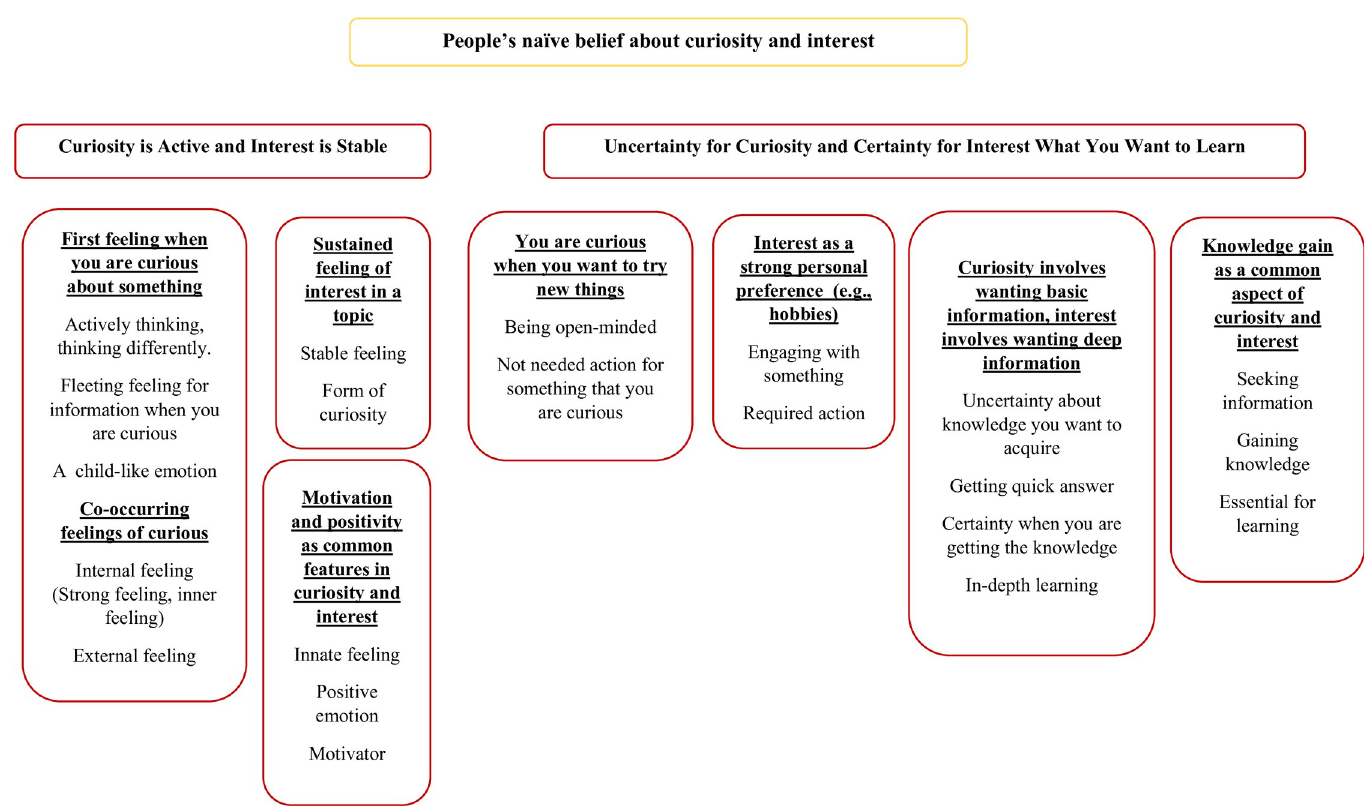
Fig 1. Diagram showing the transcript topic (level 1), themes (level 2), sub-themes (level 3), and higher-level codes (level 4) [49].